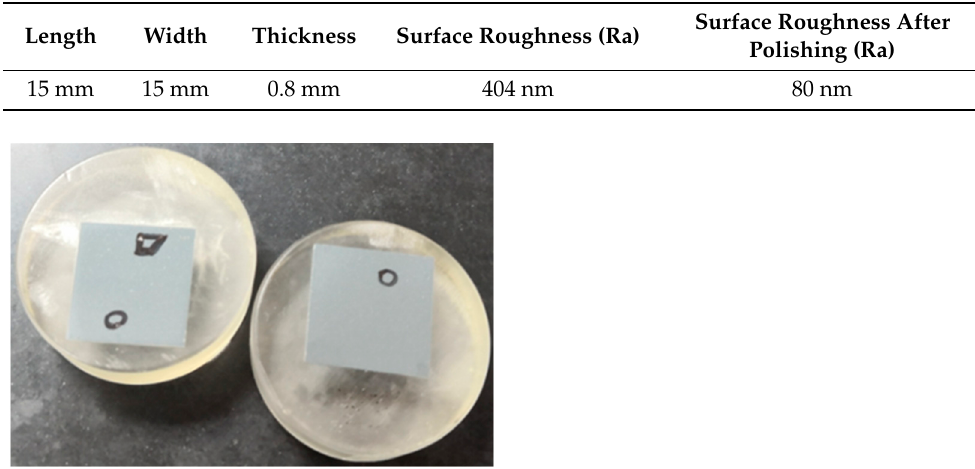
Table 2. The dimensions of Si 3 N 4 specimens for scratching and indentation tests.